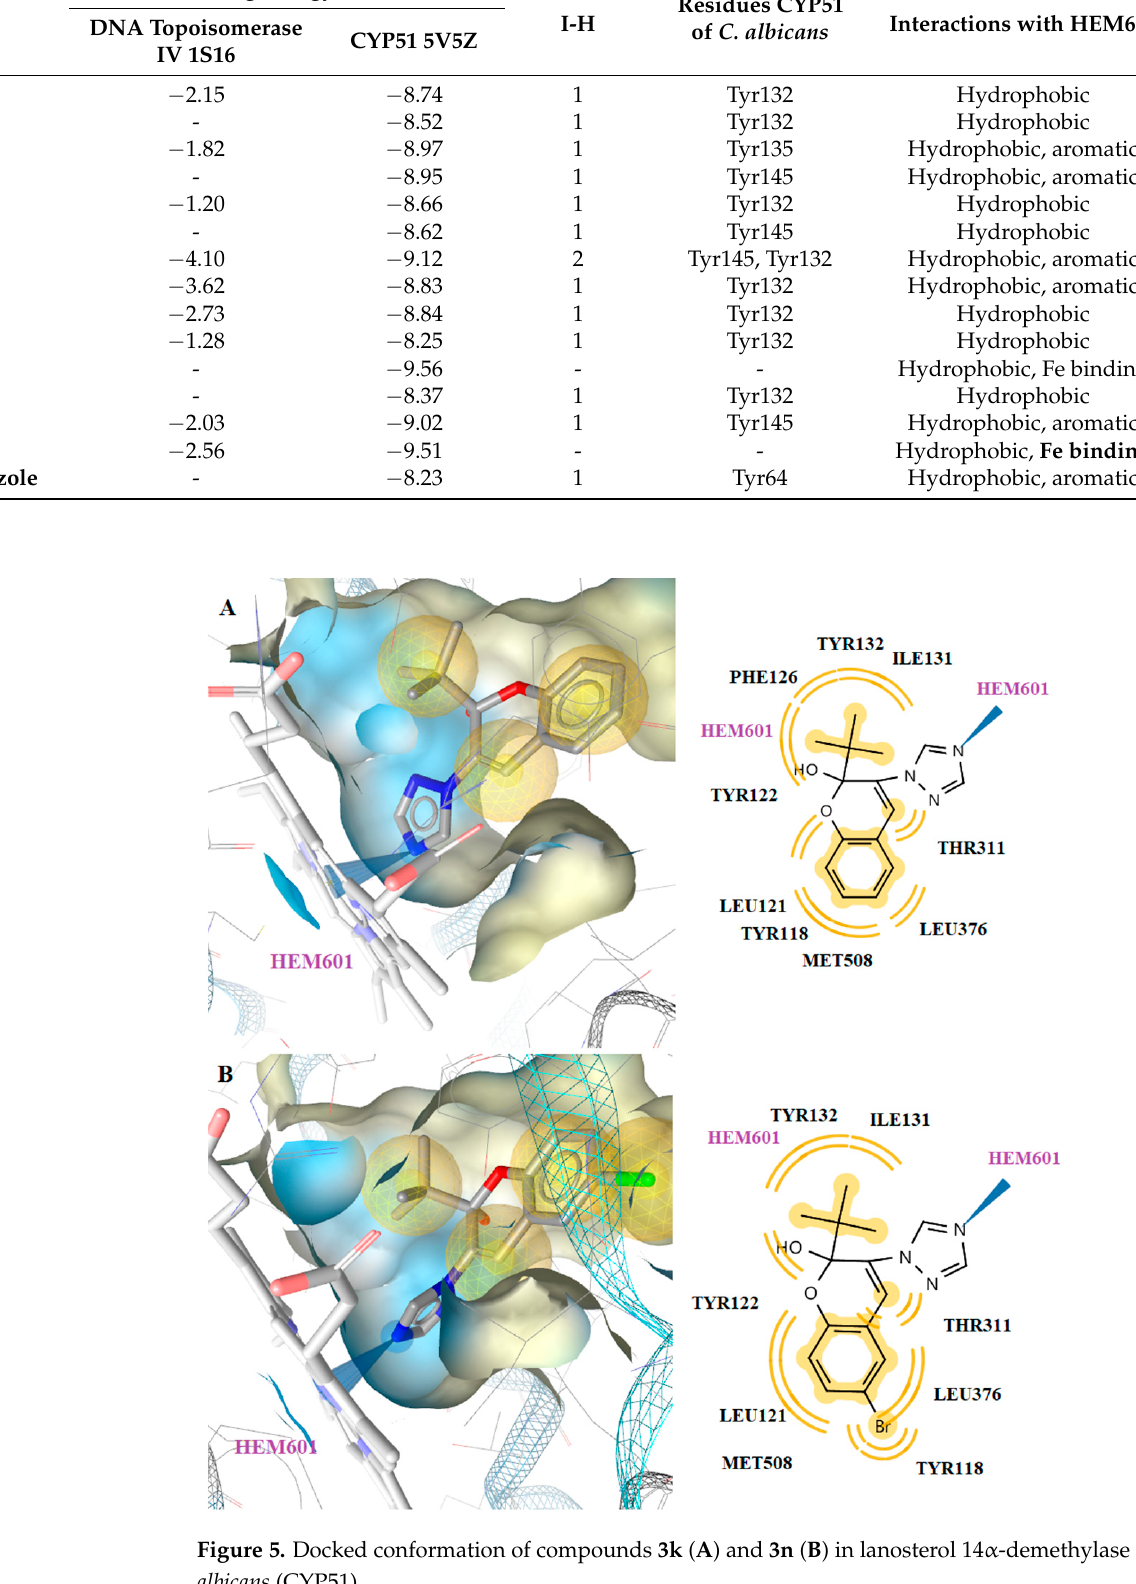
Figure 6. Docking of ketoconazole on CYP51of Candida albicans.